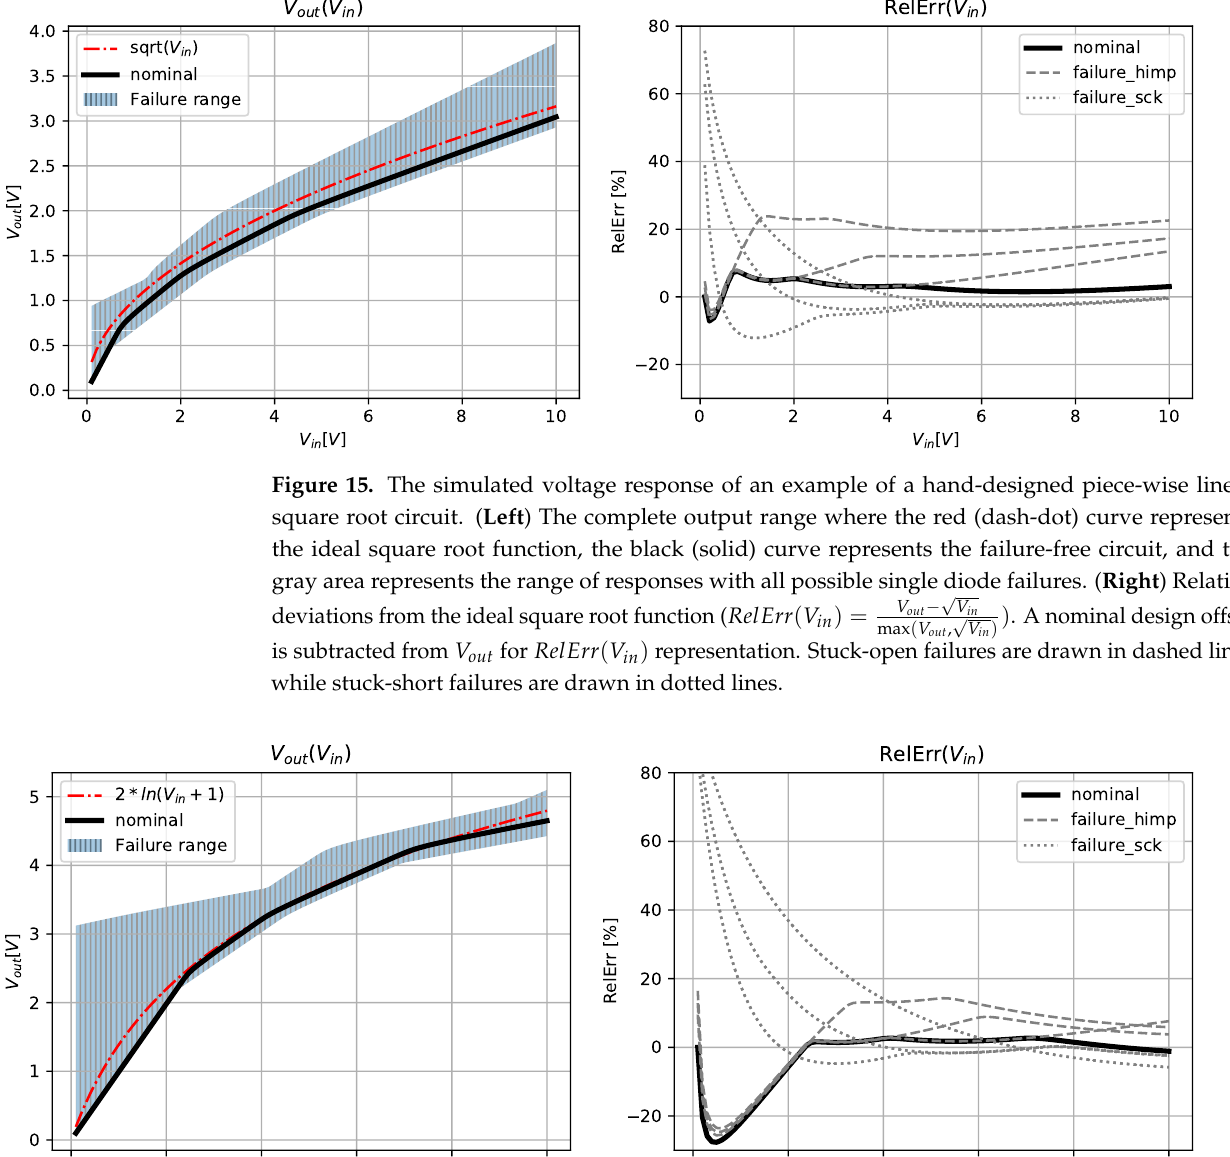
Figure 16. The simulated voltage response of an example of a hand-designed piece-wise linear the natural logarithm circuit. ( Left ) The complete output range where the red (dash-dot) curve represents the ideal natural logarithm function, the black (solid) curve represents the failure-free circuit, and the gray area represents the range of responses with all possible single diode failures. ( Right ) Relative deviations from the ideal natural logarithm function ( RelErr ( V in ) = V out failures are drawn in dashed lines while stuck-short failures are drawn in dotted